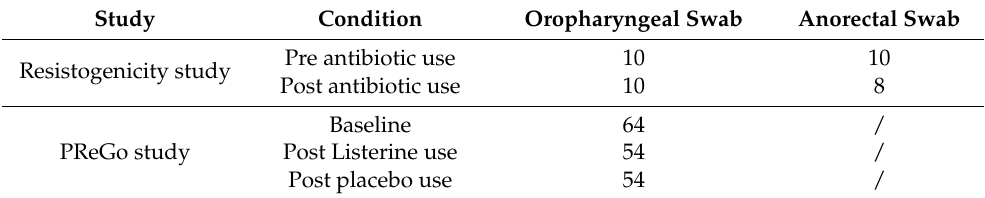
Table 1. Oropharyngeal and anorectal ESwabs™ collected from men who have sex with men from two clinical studies at ITM Antwerp, Belgium, used for N. gonorrhoeae phage screening. Study Condition Oropharyngeal Swab Anorectal Swab Pre antibiotic use 10 10 Resistogenicity study Post antibiotic use 10 8 Baseline 64 / PReGo study Post Listerine use 54 / Post placebo use 54